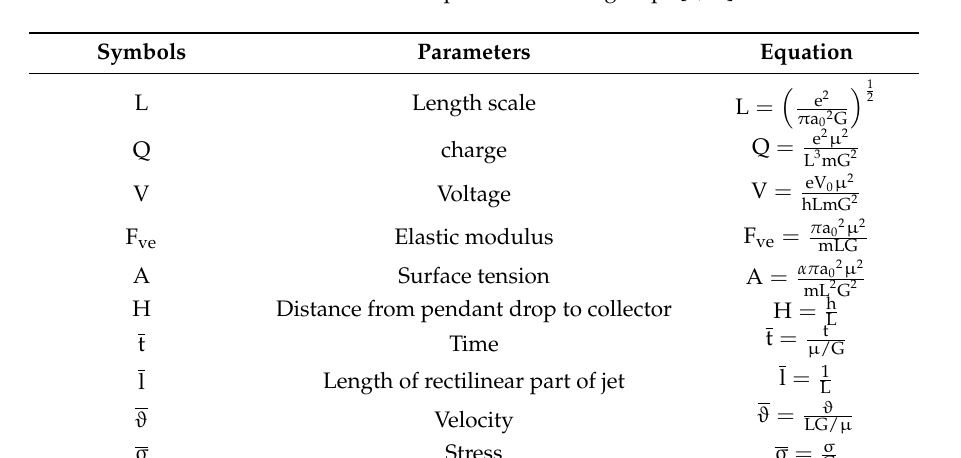
Table 1. Dimensionless parameters and groups